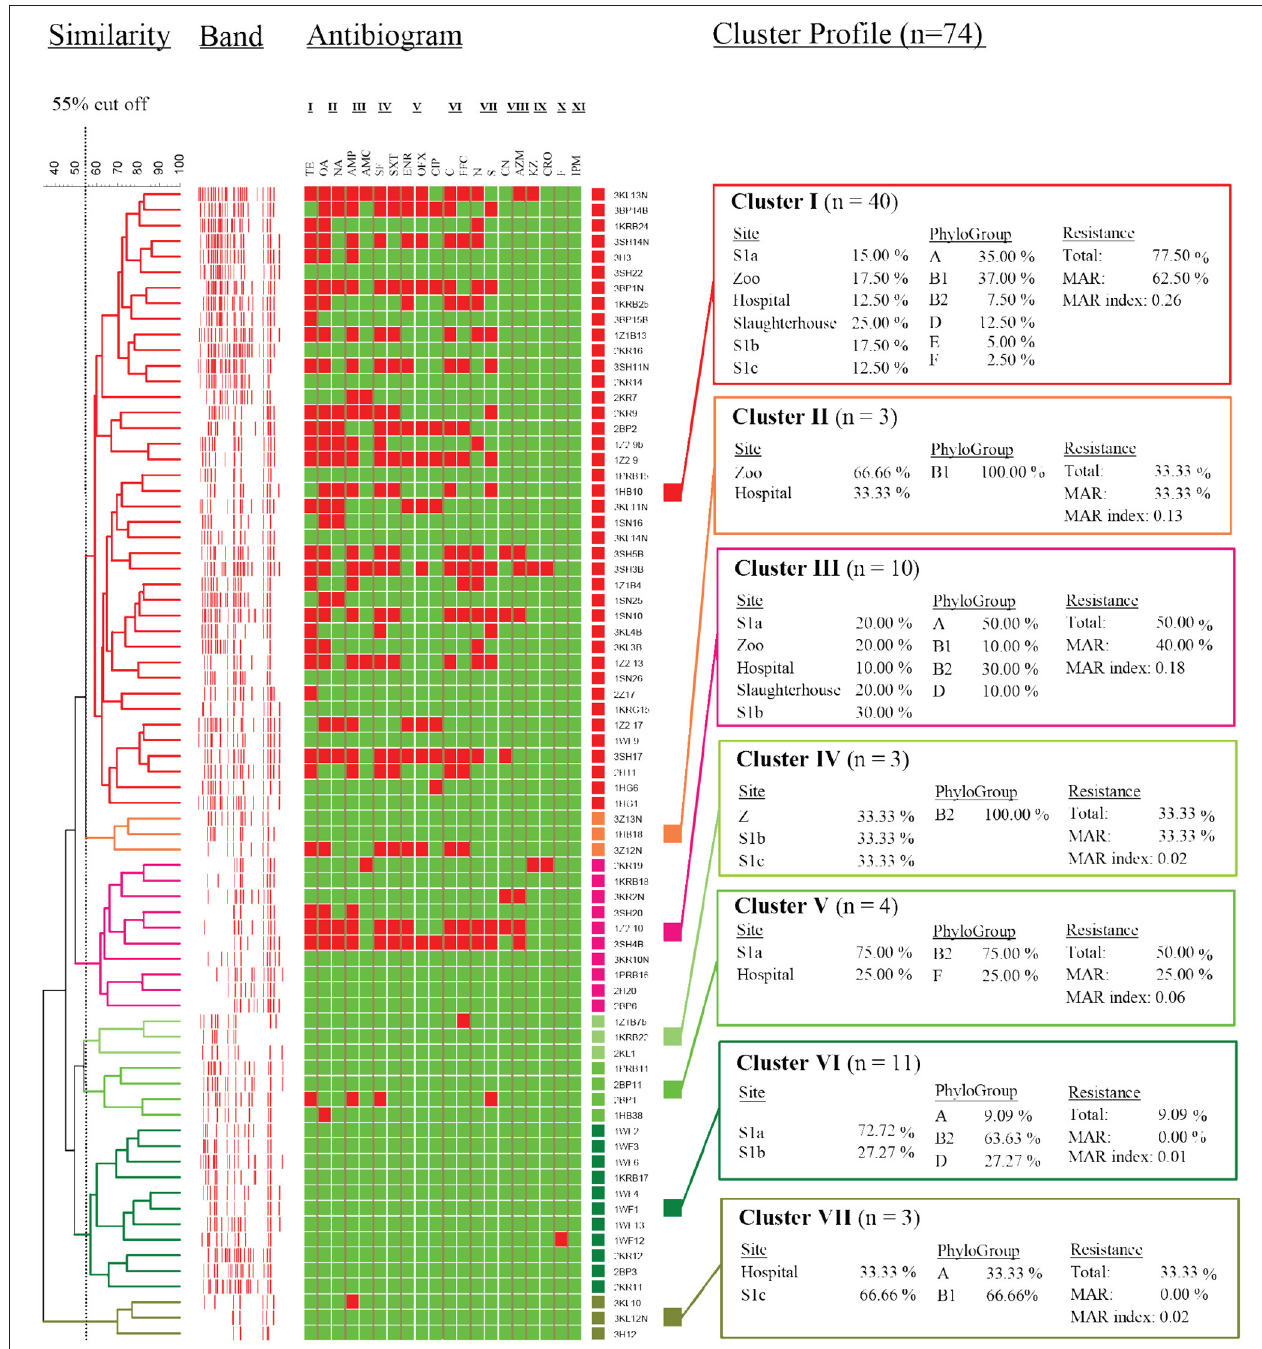
FIGURE 6 | Dendrogram showing similarity of E. coli strains isolated from different sampling sites as determined by rep-PCR fingerprint analysis using REP primer. I, Tetracycline; II, Quinolone; III, Penicilin; IV, Sulfonamide; V, Fluoroquinolone; VI, Amphenicol; VII, Aminoglycoside; VIII, Macrolide; IX, Cephalosporin; X, Nitrofuran; XI,